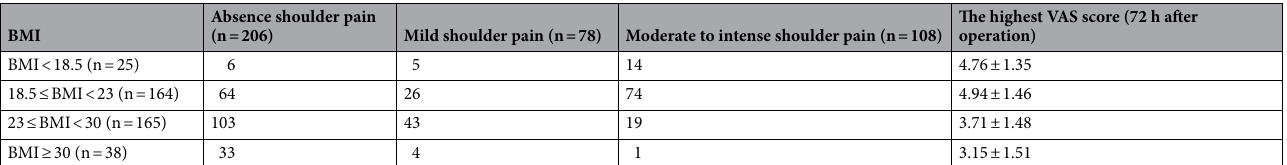
Table 3. Incidence and intensity of shoudler pain between different BMI patients. Values are presented as mean ± standard deviation or number. There was no significant difference between BMI < 18.5 Group and